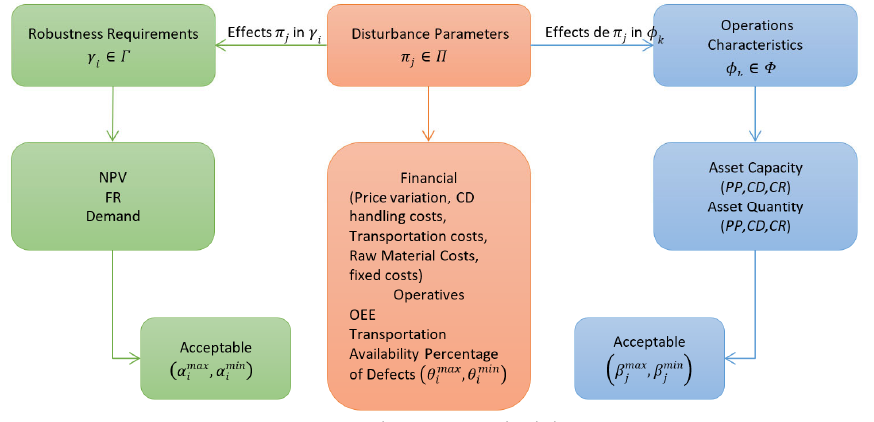
Fig. 5. Robustness Methodology